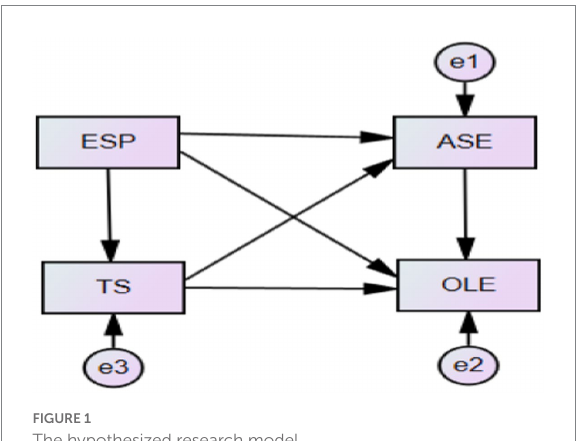
FIGURE 1 The hypothesized research